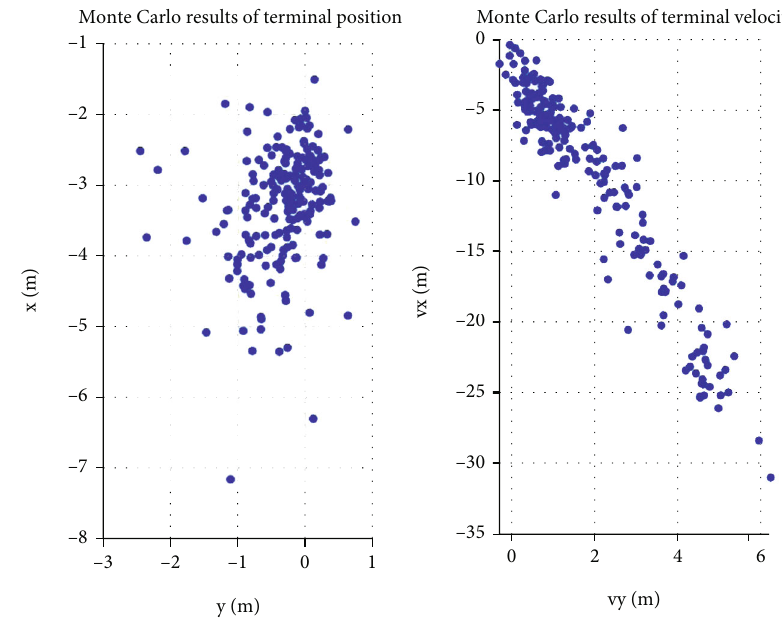
Figure 6: Monte Carlo results of terminal position and terminal